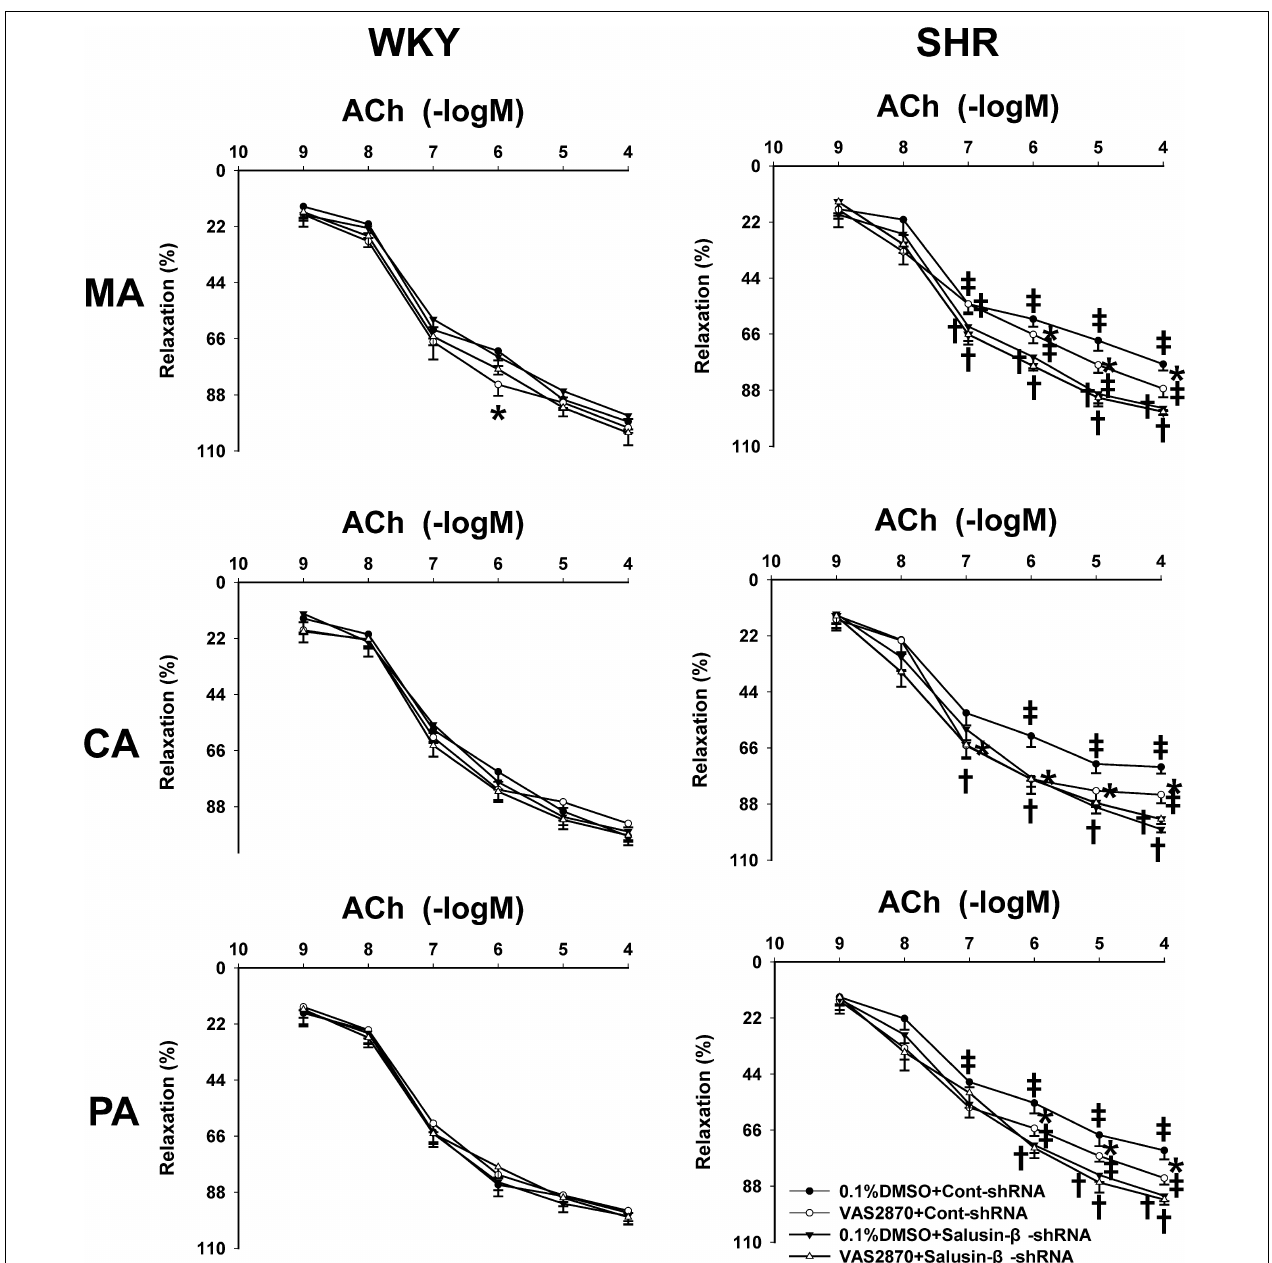
FIGURE 6 | The effects of VAS2870 on ACh-induced vascular relaxation response to salusin- β knockdown in MA, CA, and PA in WKY and SHR. Two-way ANOVA was used for data analysis, followed by Bonferrioni post hoc test to compare with the multiple groups. Values are mean ± SE. ∗ P < 0.05 compared with 0.1% DMSO, † P < 0.05 compared with Cont-shRNA. ‡ P < 0.05 compared with WKY. n = 6 for each